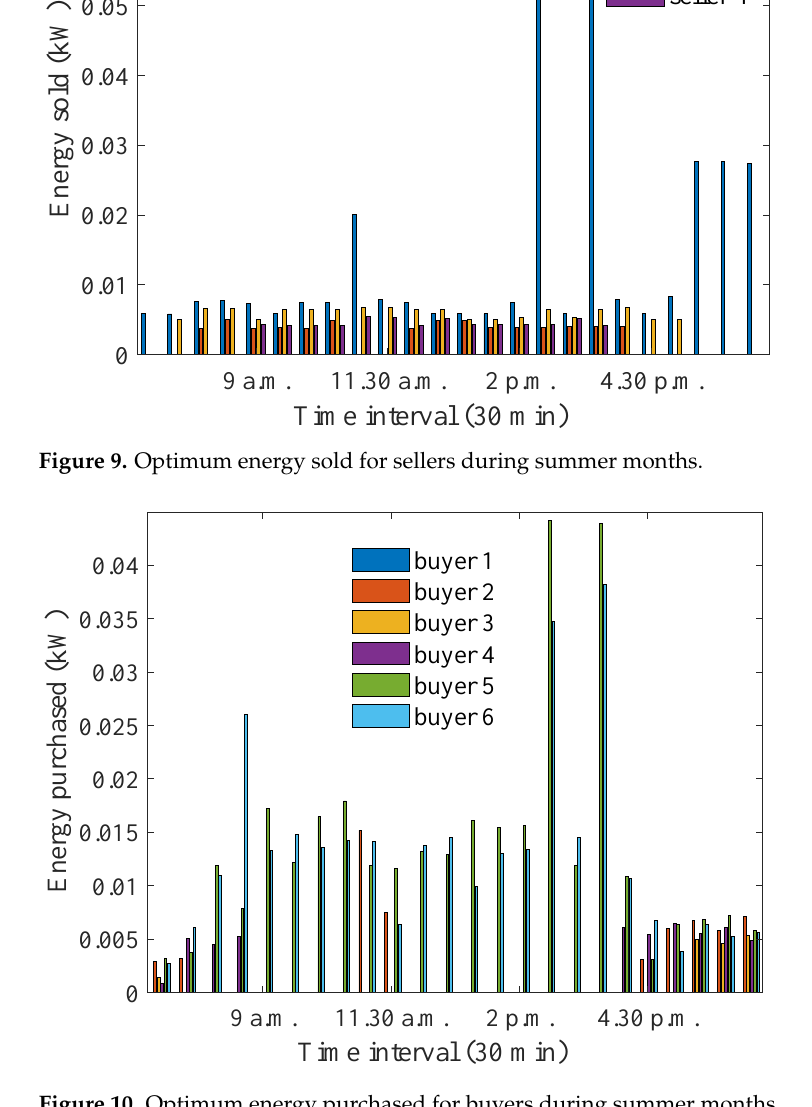
Figure 10. Optimum energy purchased for buyers during summer